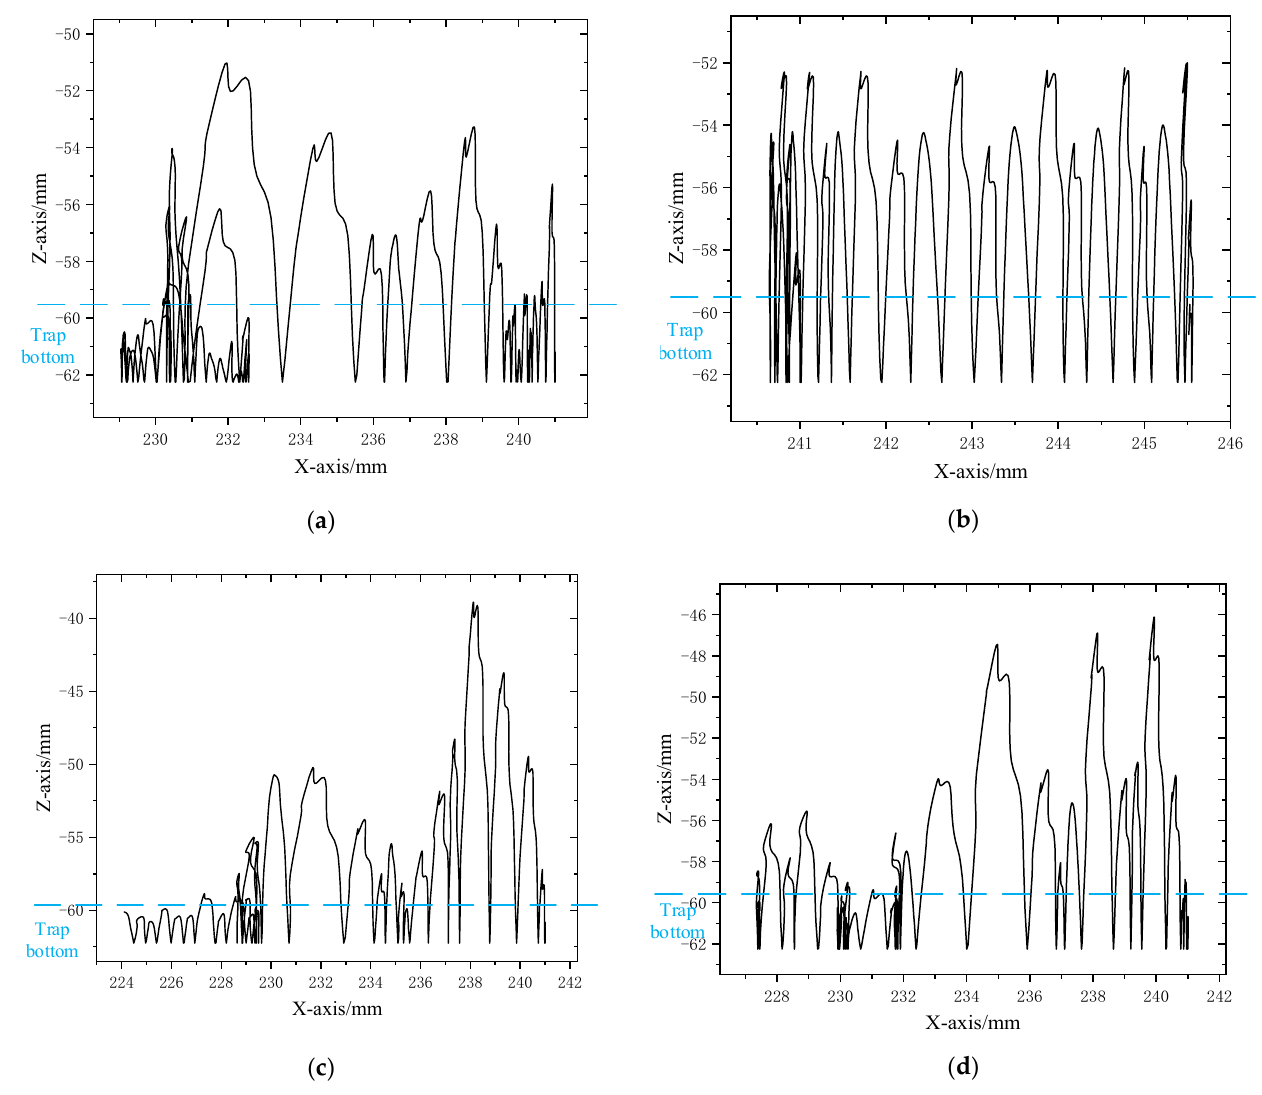
Figure 7. Particle trajectories under different initial phases: ( a ) 20°, ( b ) 40°, ( c ) 160°, and ( d ) 180°.